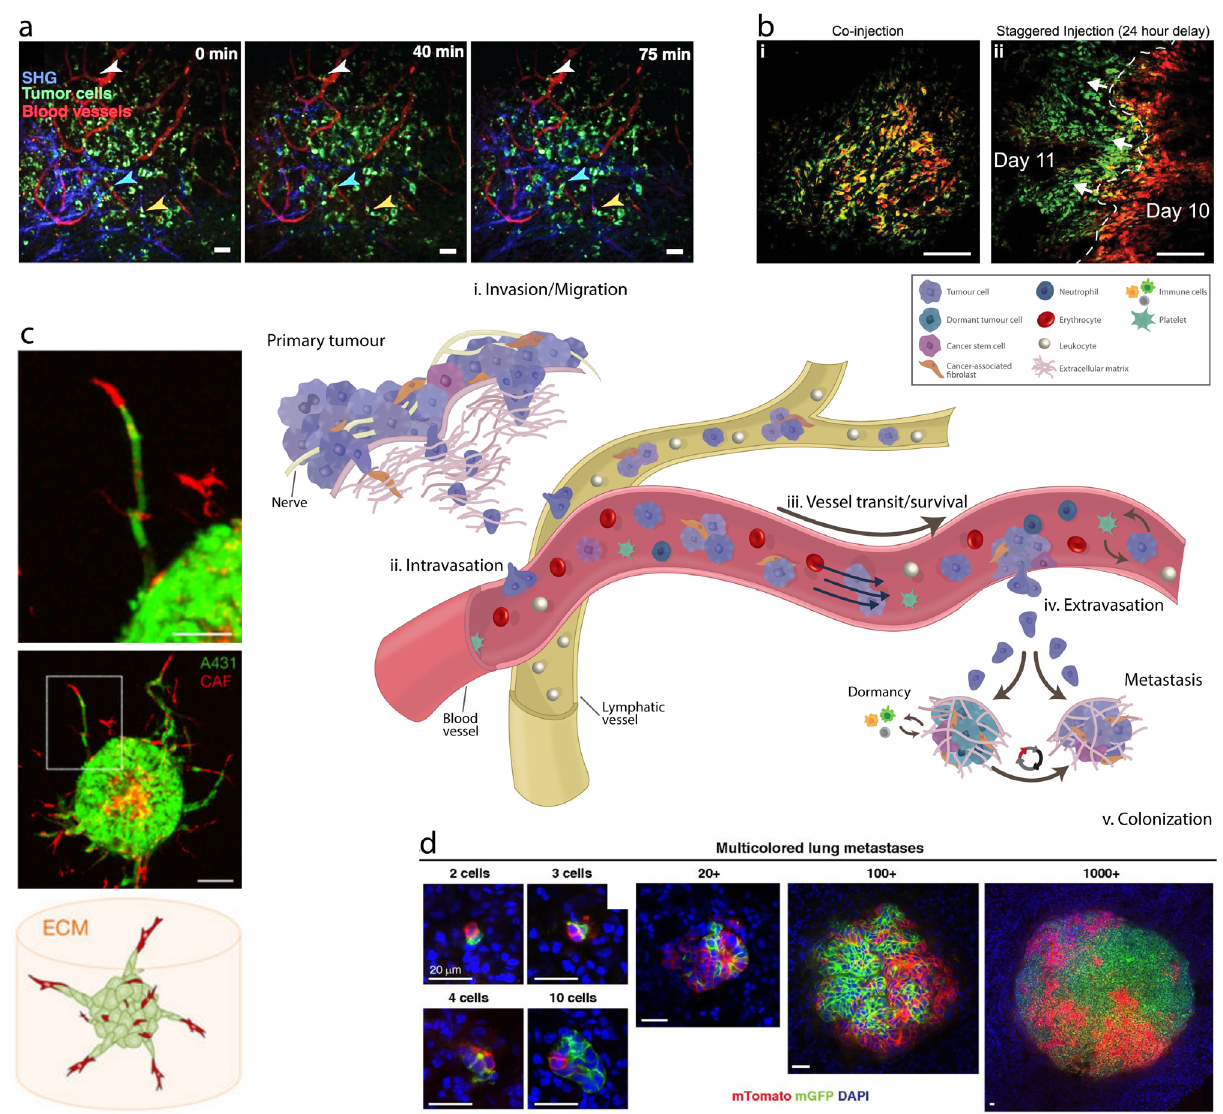
Figure 2. Advances in technologies and tools have allowed us visualise and study some of the stages of metastasis to uncover many of the different mechanisms at play. ( a ) Time-lapse intravital imaging of cancer cells (green) in association with blood vessels (red) and collagen fibres—blue, detected by second harmonic generation (SHG)—over the course of 75 minutes shows slow movement (arrowheads) of some cancer cells toward blood vessels. From Pereira et al . 69 . Reused with permission from the American Association for the Advancement of Science. ( b ) Tracking the movement of tumour hypoxia using EF5 and pimonidazole probes. Immunofluorescence of KPC xenograft tumours for EF5 (red) and pimonidazole (green) chemical indicators of tumour hypoxia after either (i) co-injection or (ii) 24-hour delayed administration. Images from Conway et al. 70 , under the terms of the Creative Commons Attribution License (CC BY) (http://creativecommons. org/licenses/by/4.0/). ( c ) Confocal images of a spheroid (1:1 mixture of cancer-associated fibroblasts [CAFs] [red] and A431 carcinoma [green] cells) after 60 hours of invasion. CAFs (red) lead collective strands of A431 cells (green). Image, originally published in Labernadie et al . 71 , used with permission from Macmillan Publishers Ltd. ( d ) Multicellular seeding is a frequent mechanism for distant metastasis. Via Cre recombinase technology, mosaic (red/green) tumour organoids are created and transplanted into non-fluorescent host mice. After 6 to 8 weeks, the lungs of these mice are harvested. Metastases arising exclusively from single-cell seeding produce only single-colour metastases (red OR green). In contrast, multicellular seeding produces metastases with both colours (red AND green). Representative micrographs of polyclonal lung metastases of different sizes from Cheung et al . 36 . Scale bars = ( a ) 50 μm and ( b , c ) 100